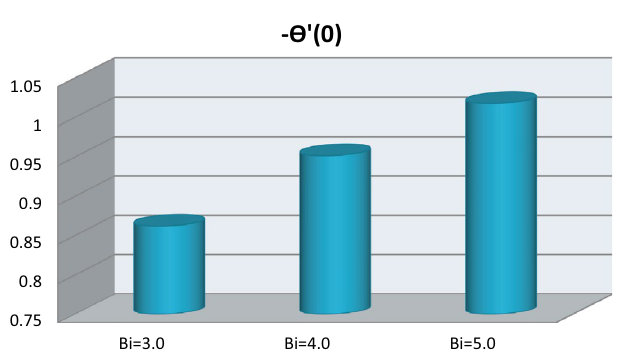
Figure 7. Local Nusselt number versus Biot number.